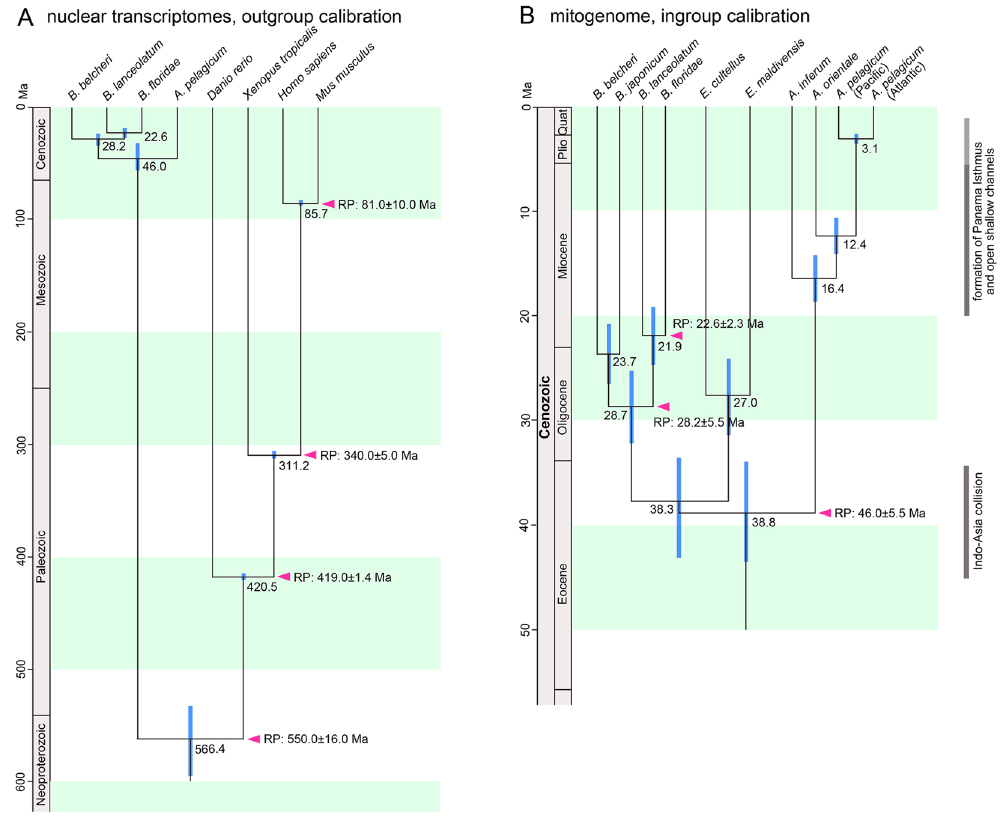
Figure 3. Divergence time estimates in amphioxus lineage. ( A ) Estimate based on nuclear transcriptome comparison calibrated with vertebrate fossil records 26 . Numerals at nodes denote estimated split time in Ma. ( B ) Estimate based on mitogenomic comparison with ingroup calibration points derived from ( A ). Timings of formation of the Isthmus of Panama 36 and of Arabia-Eurasia 38 and Indo-Asia collisions 72, 73 are also shown. Blue bars denote 95% confidence